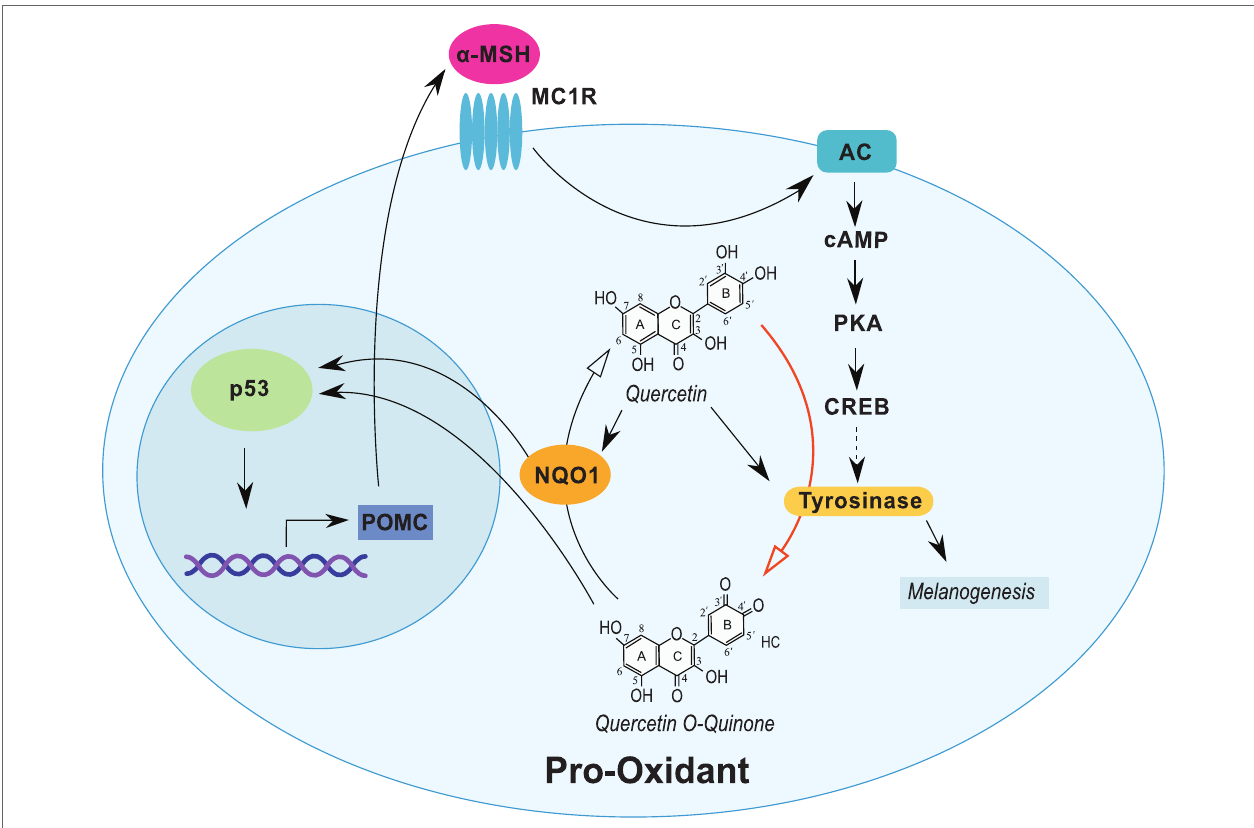
FigURe 1 | Quercetin induces tyrosinase and stress response proteins in melanocytic cells . Expression of tyrosinase in melanocytic cells is induced through the α -MSH pathway. Quercetin induces the expression of tyrosinase and several stress-responsive proteins, including NQO1 and p53. Tyrosinase oxidizes quercetin (red arrow) into an o-quinone and other reactive compounds that induce NQO1 and p53. NQO1 stabilizes p53 and can recycle activated quercetin back into the parent compound. Expression of p53 can also stimulate α -MSH activity completing a cyclical response to quercetin exposure. Open arrows indicate biochemical reactions. Closed arrows represent